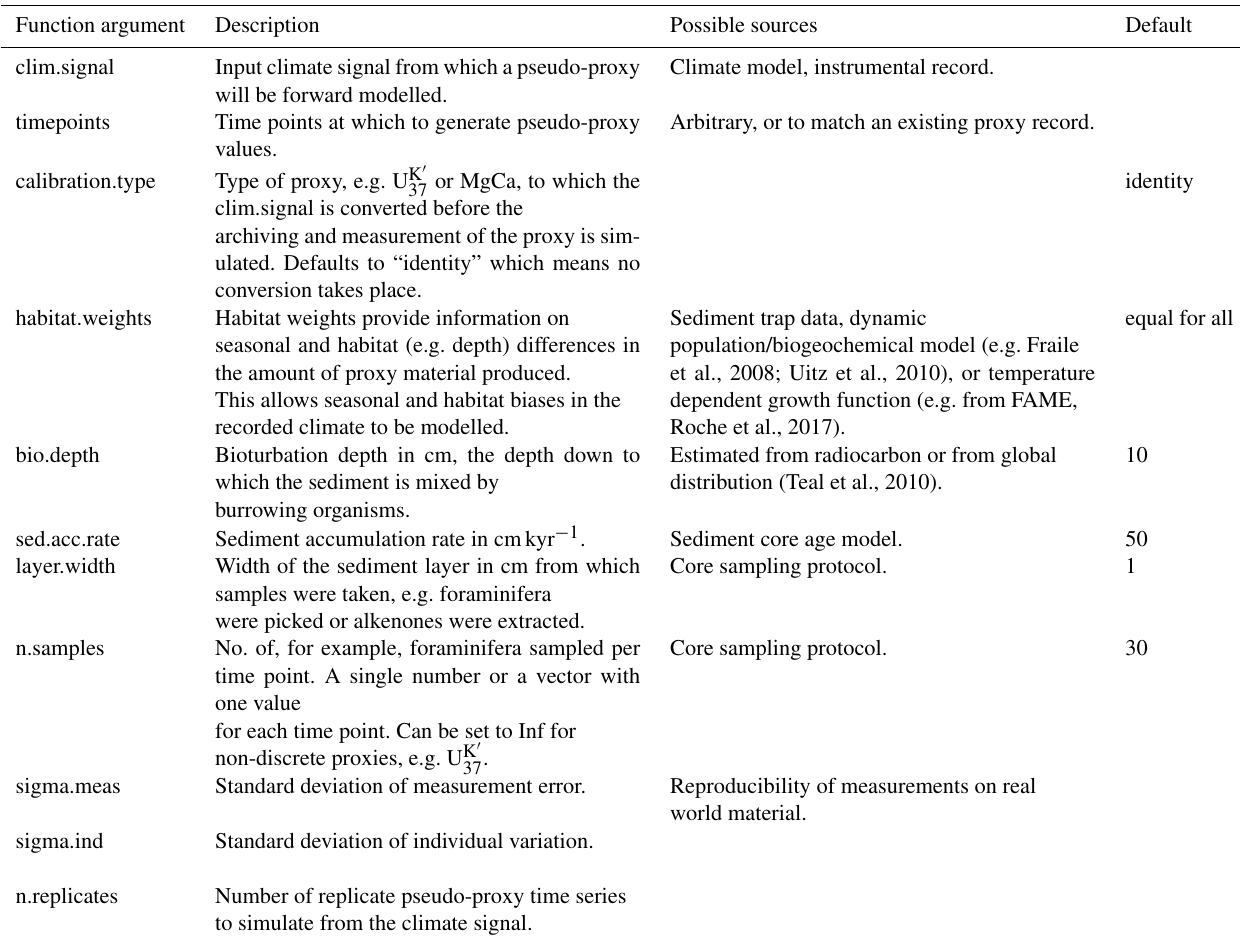
Table 1. Required input data and parameters to generate a pseudo-proxy record with sedproxy . The final argument controls the experimental design rather than the proxy record creation process